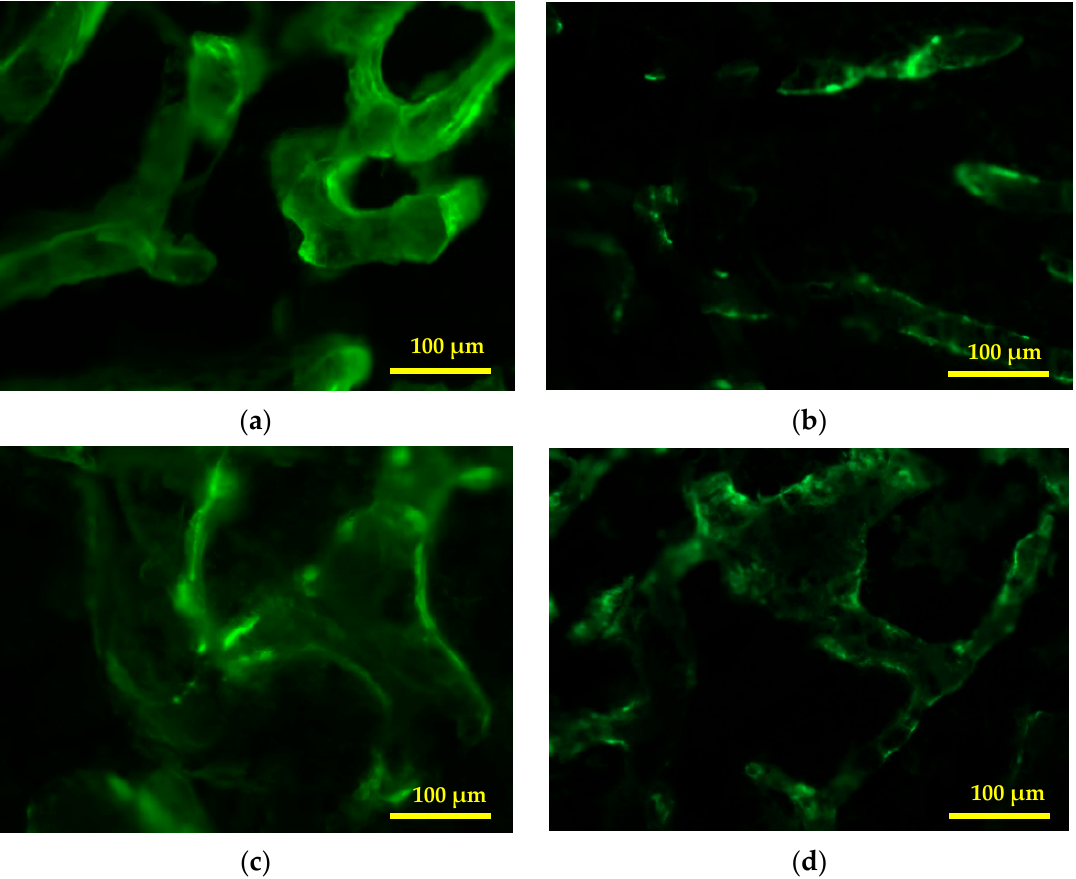
Figure 3. Photomicrograph of undecalcified trabecular bones captured with a fluorescent microscope and displayed on a computer with Image Pro-Express software for dynamic histomorphometry parameters (100X magnification): ( a ) Sham; ( b ) AC: Adrx control given IM DEX 120 μ g/kg/day; ( c ) AP: Adrx rats given IM DEX 120 μ g/kg/day and aqueous Piper sarmentosum extract 125 mg/kg/day; and ( d ) AG: Adrx rats given IM DEX 120 μ g/kg/day and GCA 120 mg/kg/day.